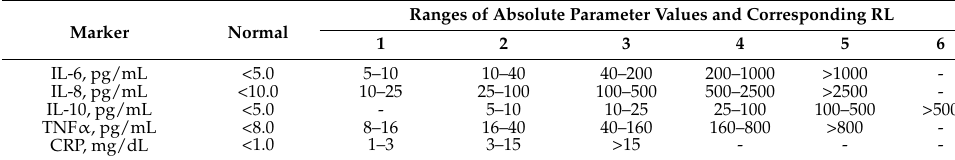
Table 1. The ranges of biomarker concentrations and their corresponding RLs. Marker